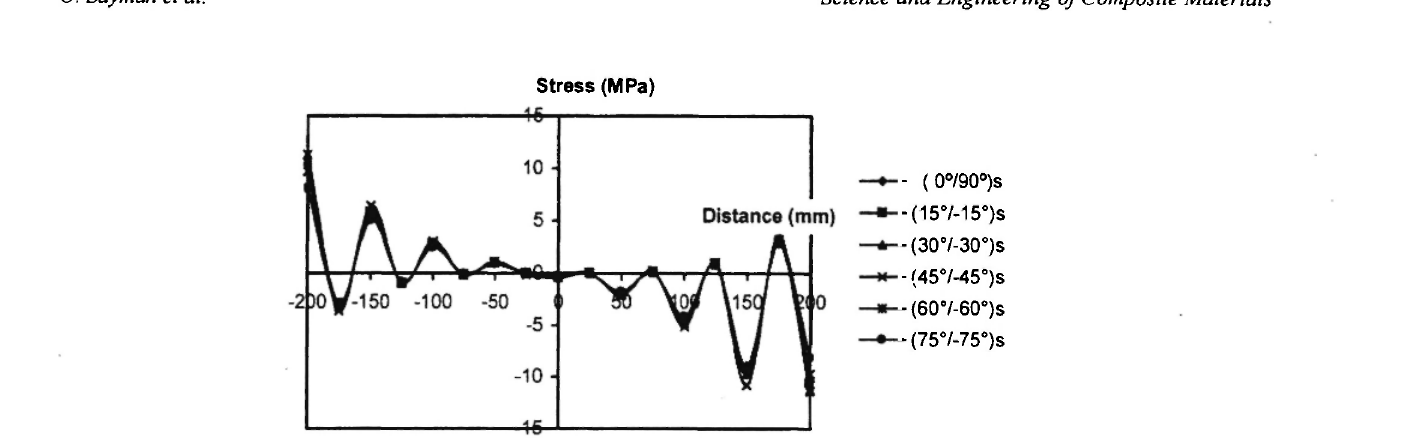
Fig. 9: Variation of the elastic-plastic stress components τ χζ at the upper surface for symmetric cross-ply and angle-ply laminated plates.